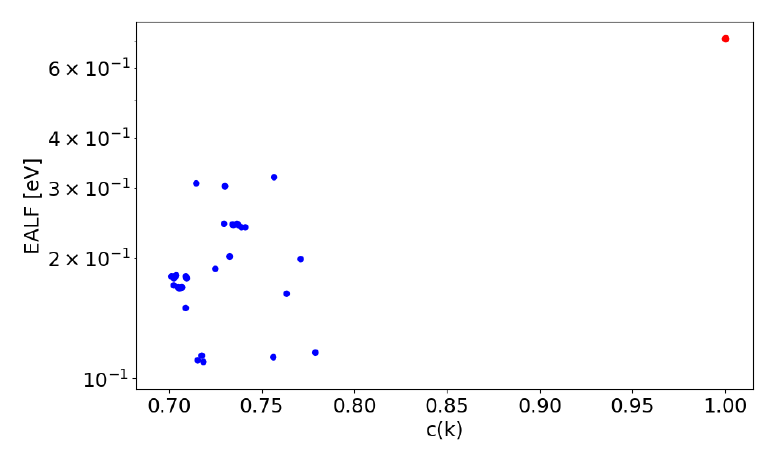
Figure 2d. Updated EALF for the relevant experiments and Case 2.